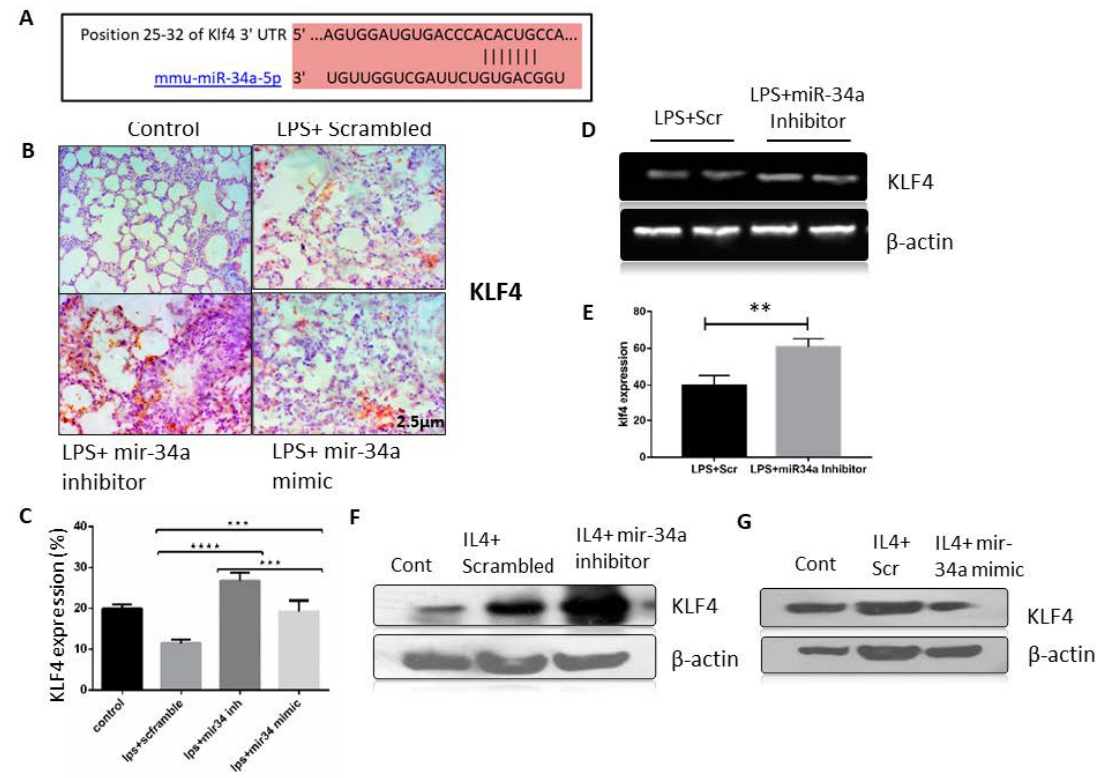
Figure 4. mir-34a targets KLF4 in lung macrophages. ( A ) Mir-34a-5p aligned with Klf4 to depict the putative binding site corresponding to ‘3’ untranslated region (UTR) region of Klf4 mRNA. ( B ) IHC staining of Klf4 in lungs of different treatment groups was done, and ( C ) counting of positive cells was performed to determine the expression of Klf4 in mice lung tissue and was analyzed by two-way ANOVA following Tukey’s post hoc analyses ( D , E ). RT-PCR results for the gene Klf4 from the lung tissue on 1.5% agarose gel and its densitometry by normalizing against actin. Statistical significance was done by t-test. ( F , G ) Immunoblots of Klf4 from RAW264.7 macrophage transfected with miR-34a inhibitor or mimic. ** p < 0.01, *** p < 0.001, **** p < 0.0001 (a minimum of four animals were used for each study).